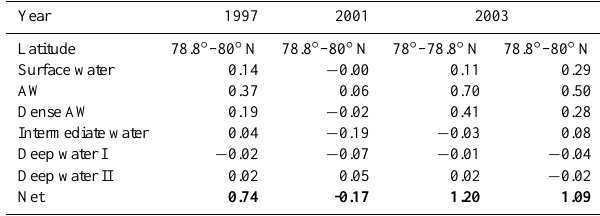
Table 4. Volume transports (Sv) (positive westward) from the meridional sections with no constraints applied.